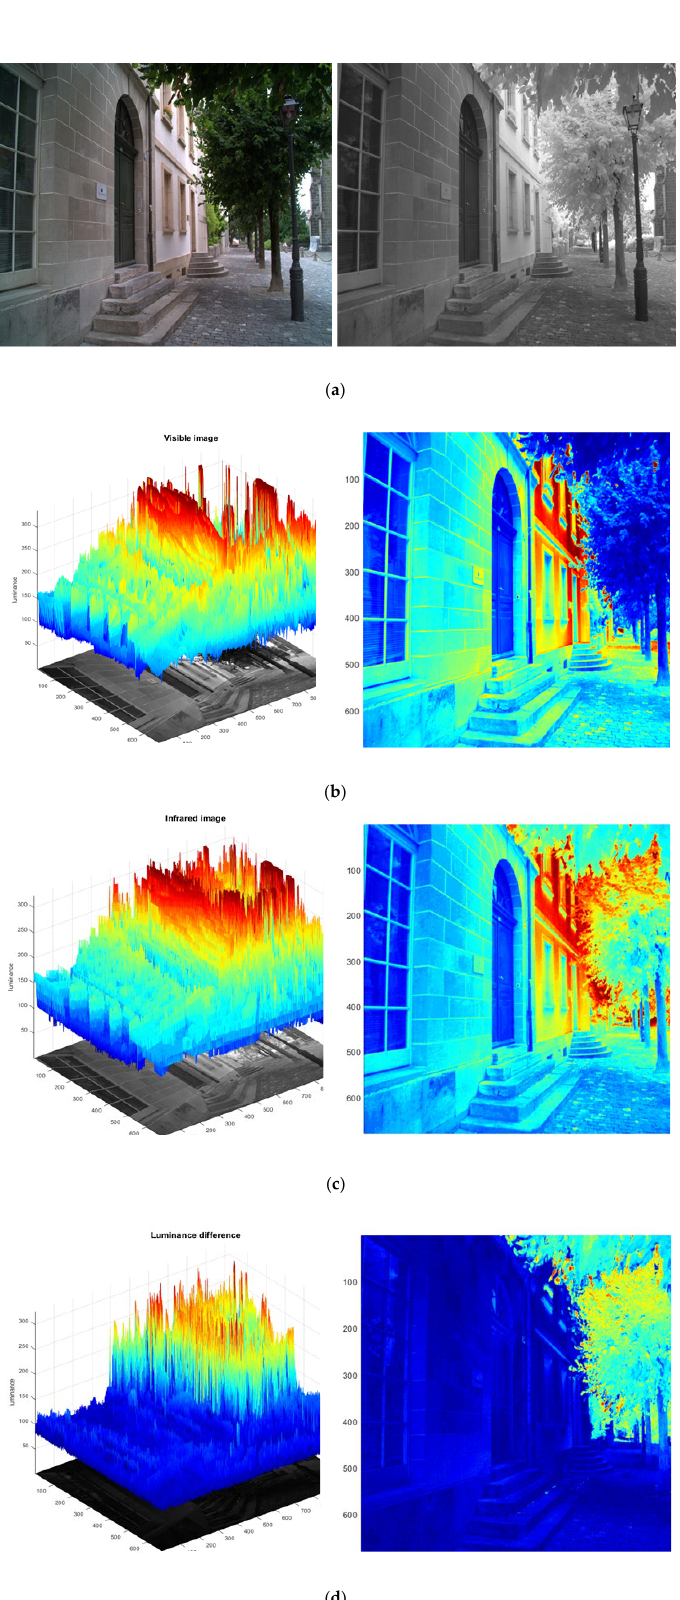
Figure 8. Color maps of daytime images: ( a ) daytime visible and near-infrared images ( b ) daytime visible images, ( c ) daytime near-infrared images, ( d ) difference images between daytime visible and near-infrared.